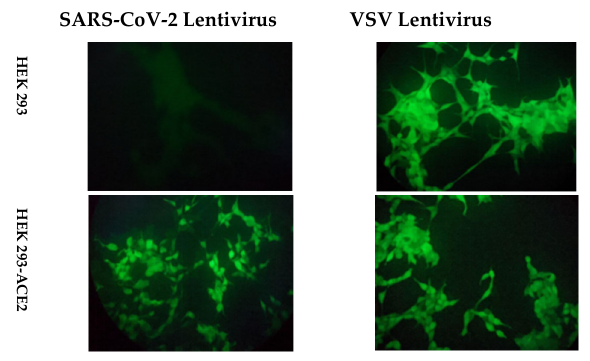
Figure 2. GFP expression following LV transduction, indicating the specificity of SARS-CoV-2 spike-expressing LV in binding HEK 293-ACE2 cells.